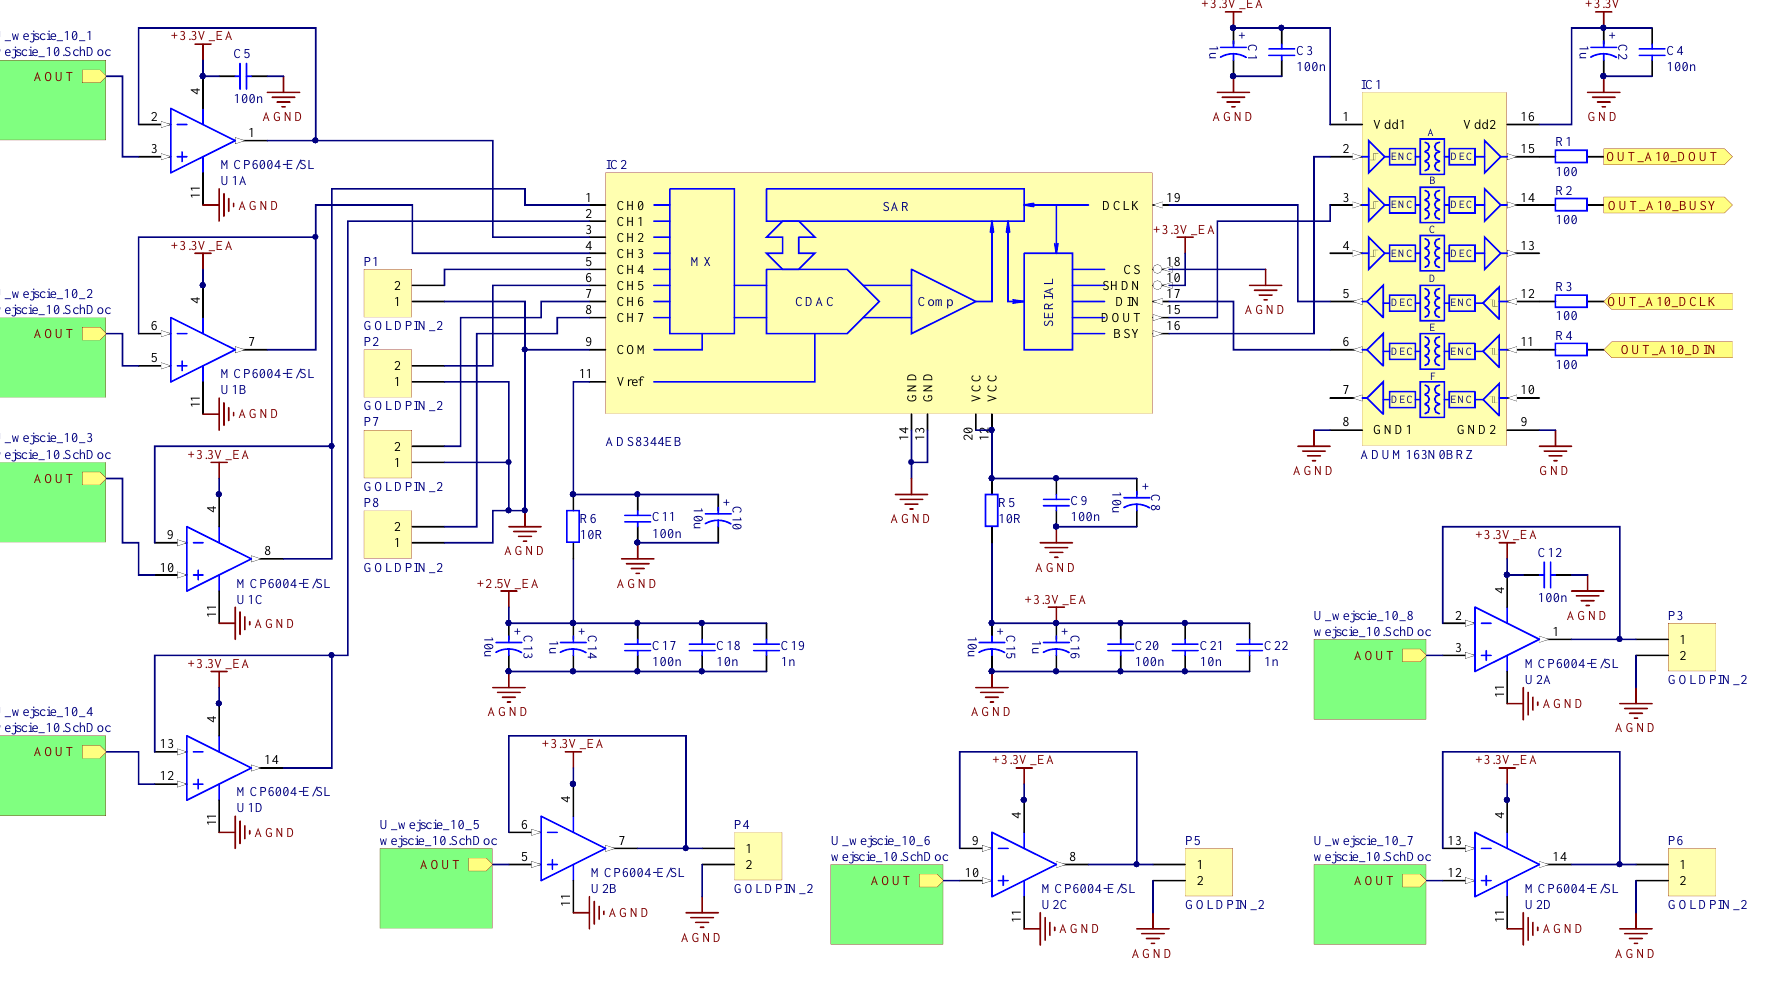
Figure 2. Analog input circuit